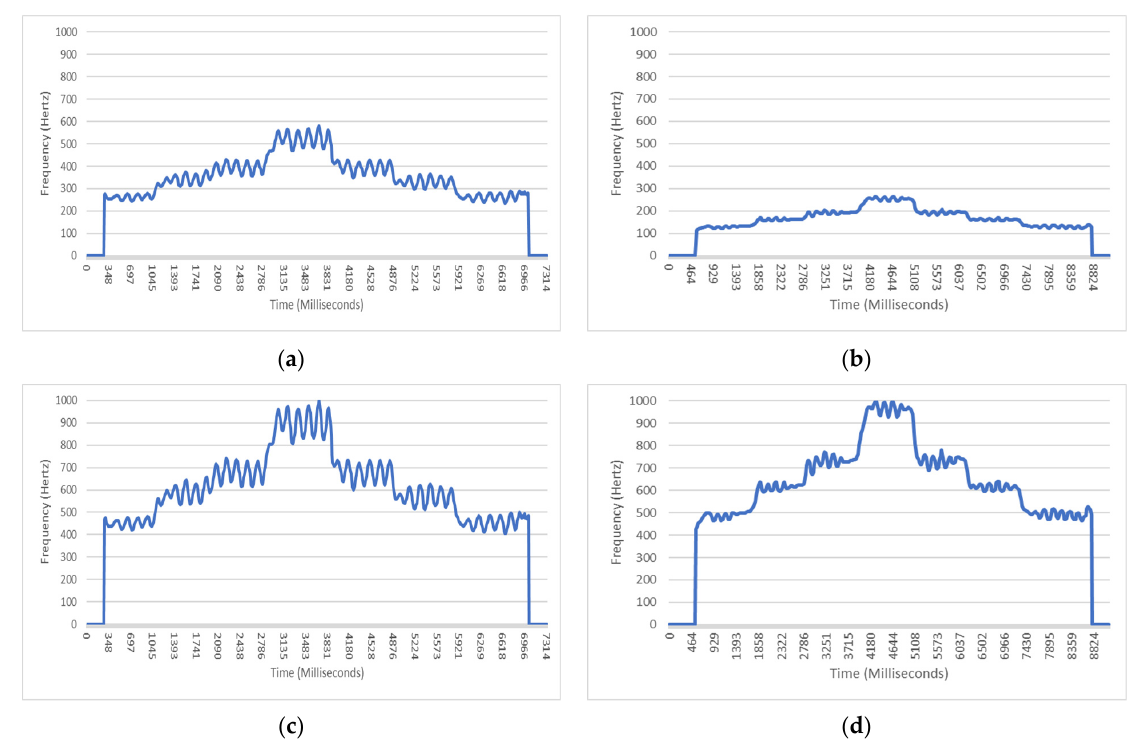
Figure 2. The effect of stretching on pitch contour’s slopes. ( c , d ) are the stretched pitch contours of ( a , b ), respectively.